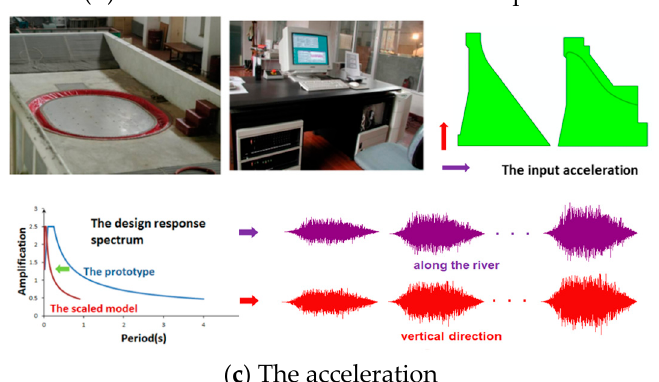
Figure 3. The test model of Huangdeng gravity dam.